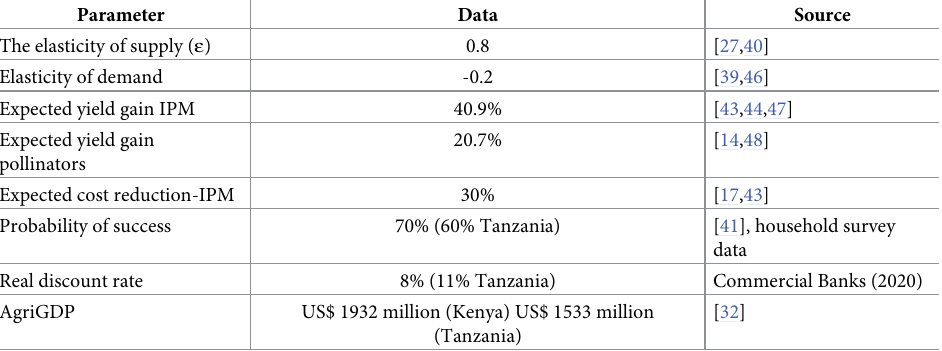
Table 1. Parameters for the economic surplus model used to estimate the impact of integrated pest and pollinator management in Kenya and